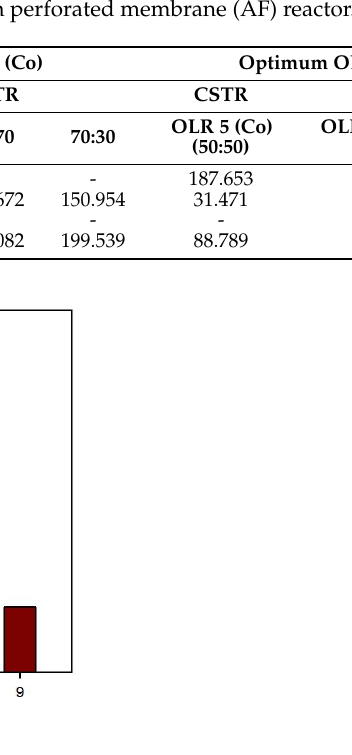
Table 8. Volatile Fatty Acids (VFA) during different organic loading rates (OLRs) for continuous stirred tank reactor (CSTR) and anaerobic filter with perforated membrane (AF) reactor.